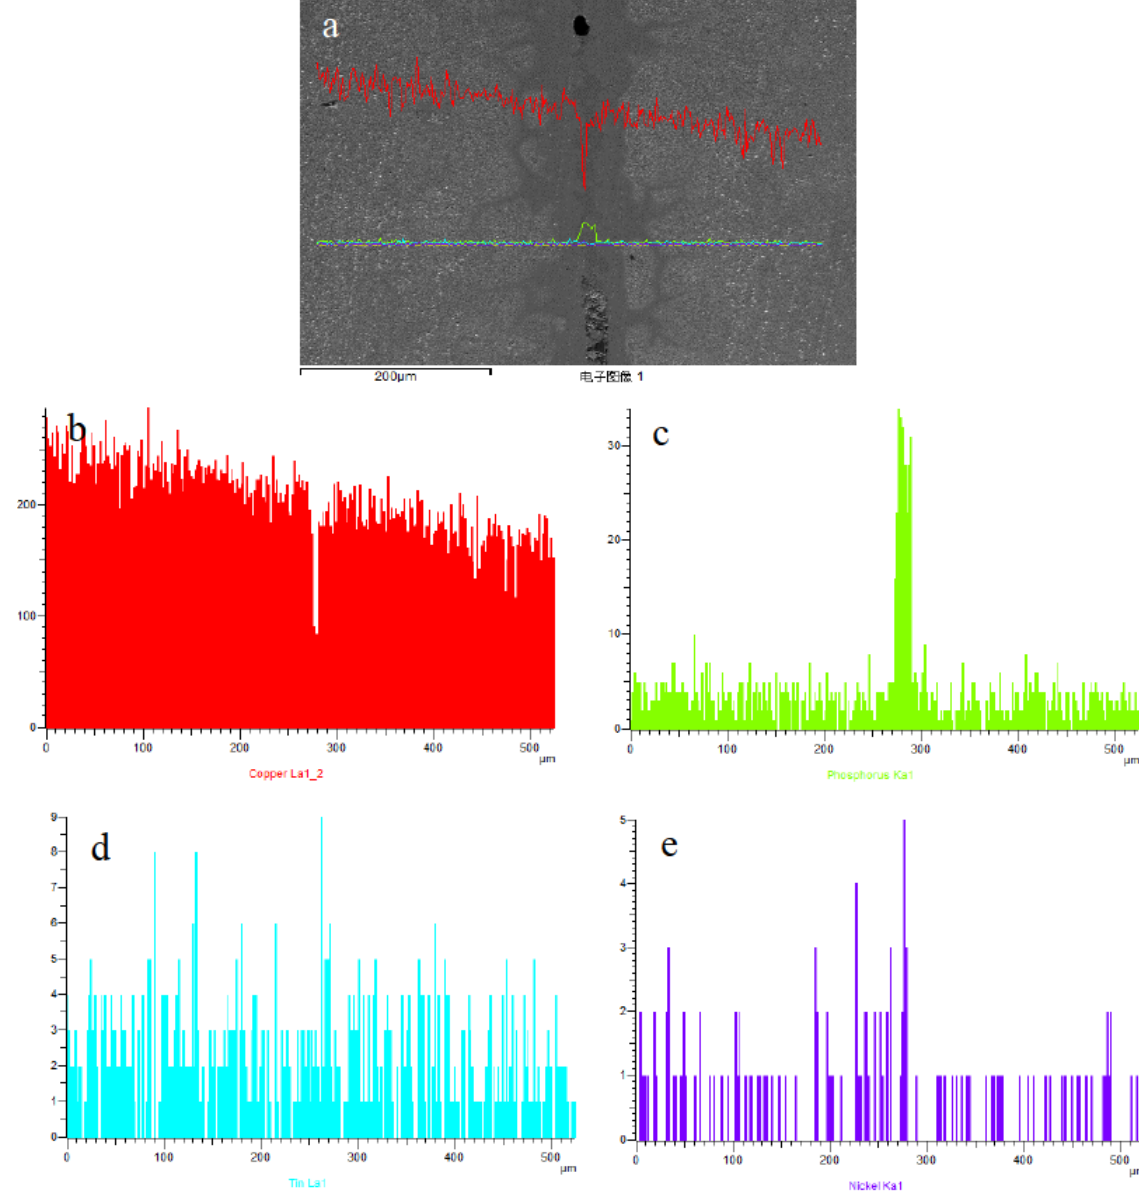
Figure 11: Energy-dispersive spectra elemental line scan results of the brazing joint of the crystalline filler metal at 660 ∘ C, showing the (a) line scan position on the micrograph, and the distribution of the (b) Cu, (c) P, (d) Sn and (e) Ni elements along the line